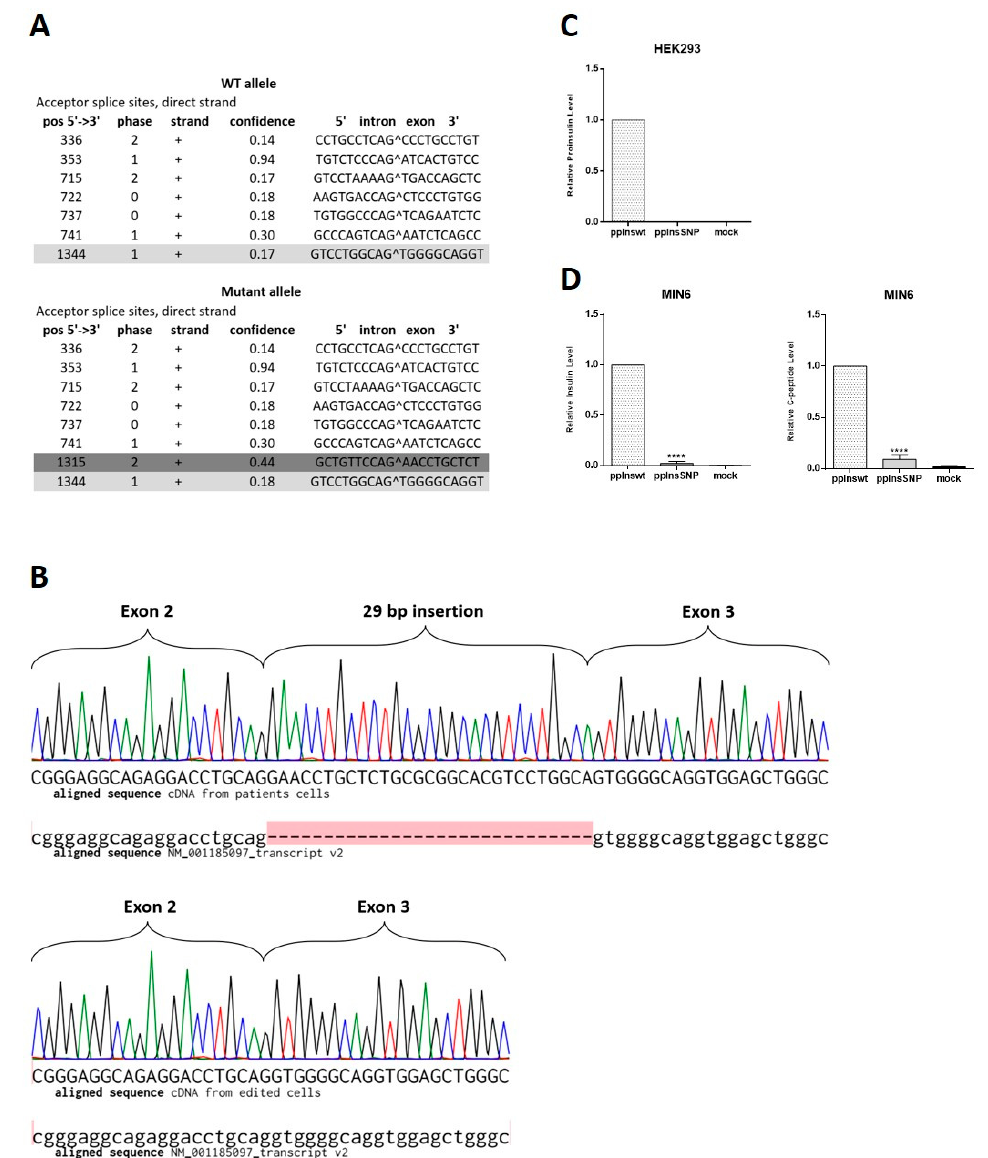
Figure 4. The c.188-31G>A INS splice variant detection and analysis of its influence on insulin expression. ( A ) Splice variant prediction. Dark grey color shows normal splice site between exon 2 and 3 with the confidence 0.17. Bright grey color marks the new ectopic splice site with the higher confidence (0.44) in comparison with the normal site (0.18). ( B ) Sequencing chromatograms of the region of INS cDNA obtained from mRNA of iPSC-derived beta-like cells aligned to H. sapiens insulin, transcript variant 2, mRNA (NM_001185097.2). Upper panel shows mutant allele in cDNA library from patient’s cells, where the red highlight indicates 29 bp insertion that is absent in NM_001185097.2, lower panel shows wild type allele in cDNA library from CRISPR/Cas9-edited cells. ( C ) HEK293 cells were transiently transfected with pcDNA3.1-preproIns wild type or SNP. The data are normalized to activity of beta-galactosidase. Intracellular level of proinsulin is shown as means ± SD ( n = 3). ( D ) MIN6 insulinoma cells were transiently transfected with pcDNA3.1-preproIns wild type or SNP. Intracellular levels of synthesized insulin (left) and C-peptide (right) are shown as means ± SD ( n = 3); **** p < 0.0001.